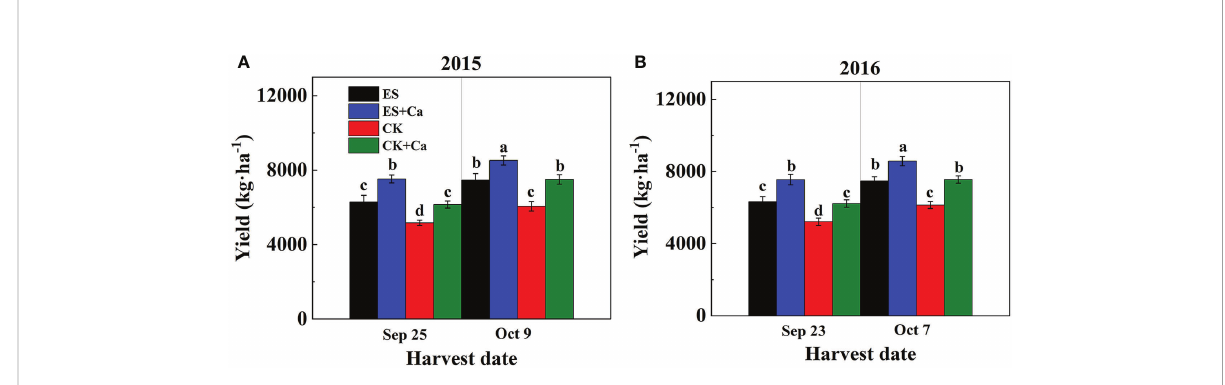
FIGURE 11 Effects of exogenous foliar calcium (Ca 2+ ) application on peanut yield under early and normal sowing scenarios during (A) 2015 and (B) 2016. Values are means ± SD (n = 3). Different letters indicate signi fi cant differences according to Duncan ’ s multiple range tests ( p <